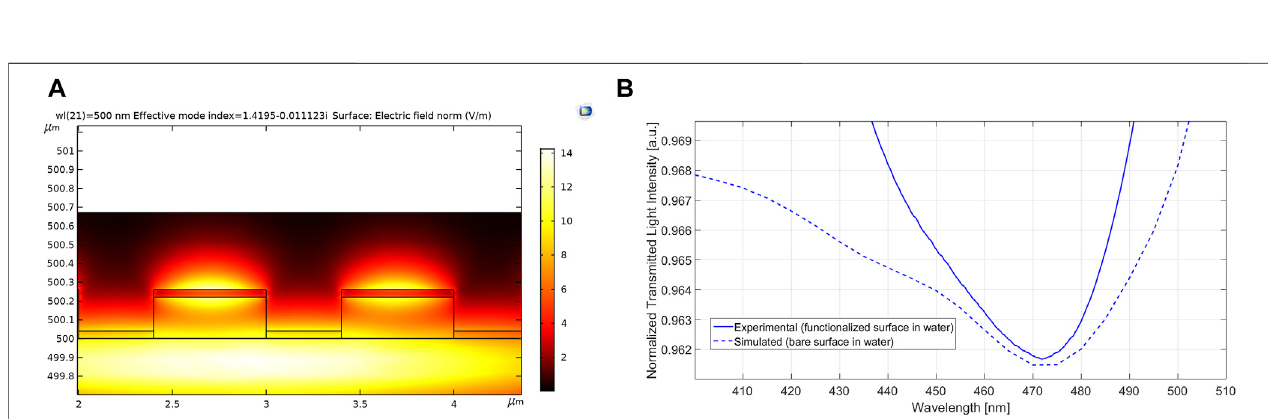
FIGURE 5 | Numerical results based on a mode analysis of the nanoplasmonic sensor chip, obtained by using Comsol Multiphysics. In particular, (A) shows the simulated electric fi eld norm; (B) reports the normalized transmitted spectrum relative to the fundamental mode, obtained by the normalization of the transmitted spectrum in water with the reference spectrum. In addition, to compare the numerical and the experimental resonance,the spectrum experimentally obtained exploiting the functionalized sensor chip in water has also been reported.